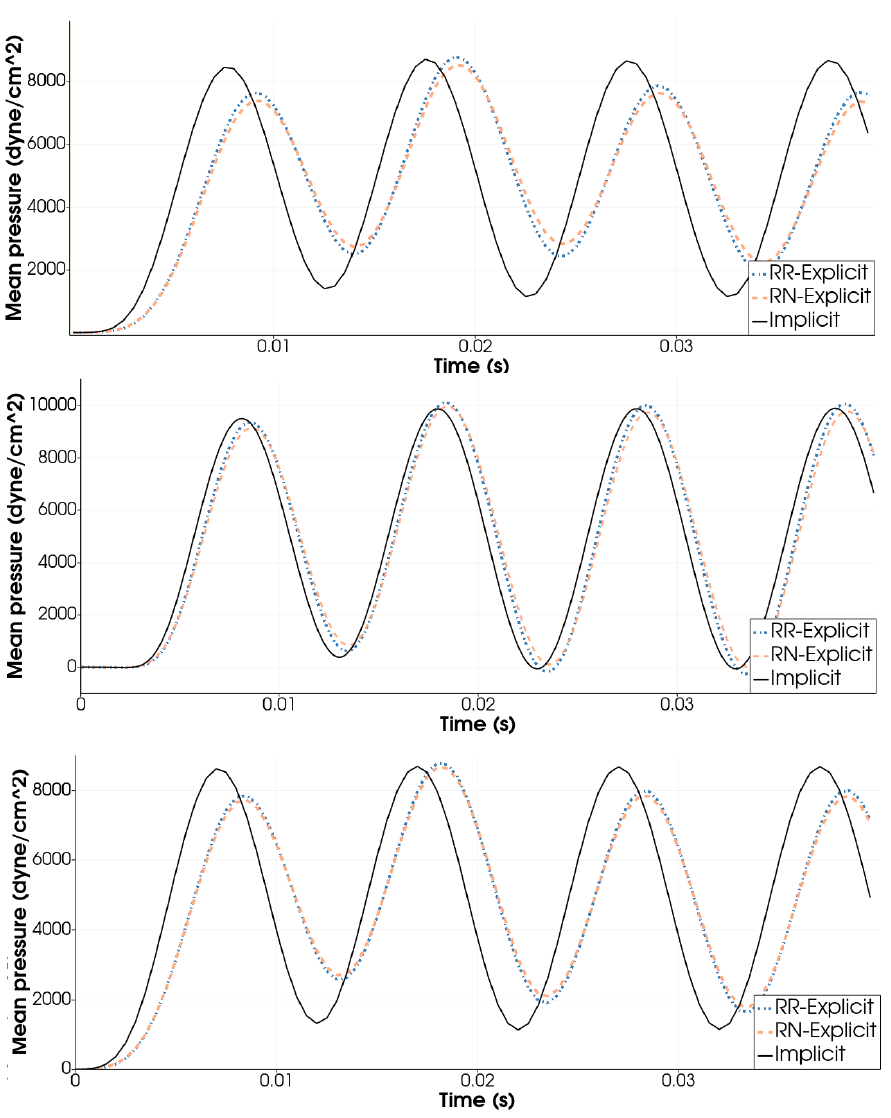
Figure 2. Mean pressure at section z = 2.5cm for (cid:98) P = 5000: ∆ t = 0.0005 s, γ ST = 1.5 × 10 5 ( t ), ∆ t = 0.000125 s, γ = 1.5 × 10 5 ( middle ), and ∆ t = 0.0005 s, γ ST